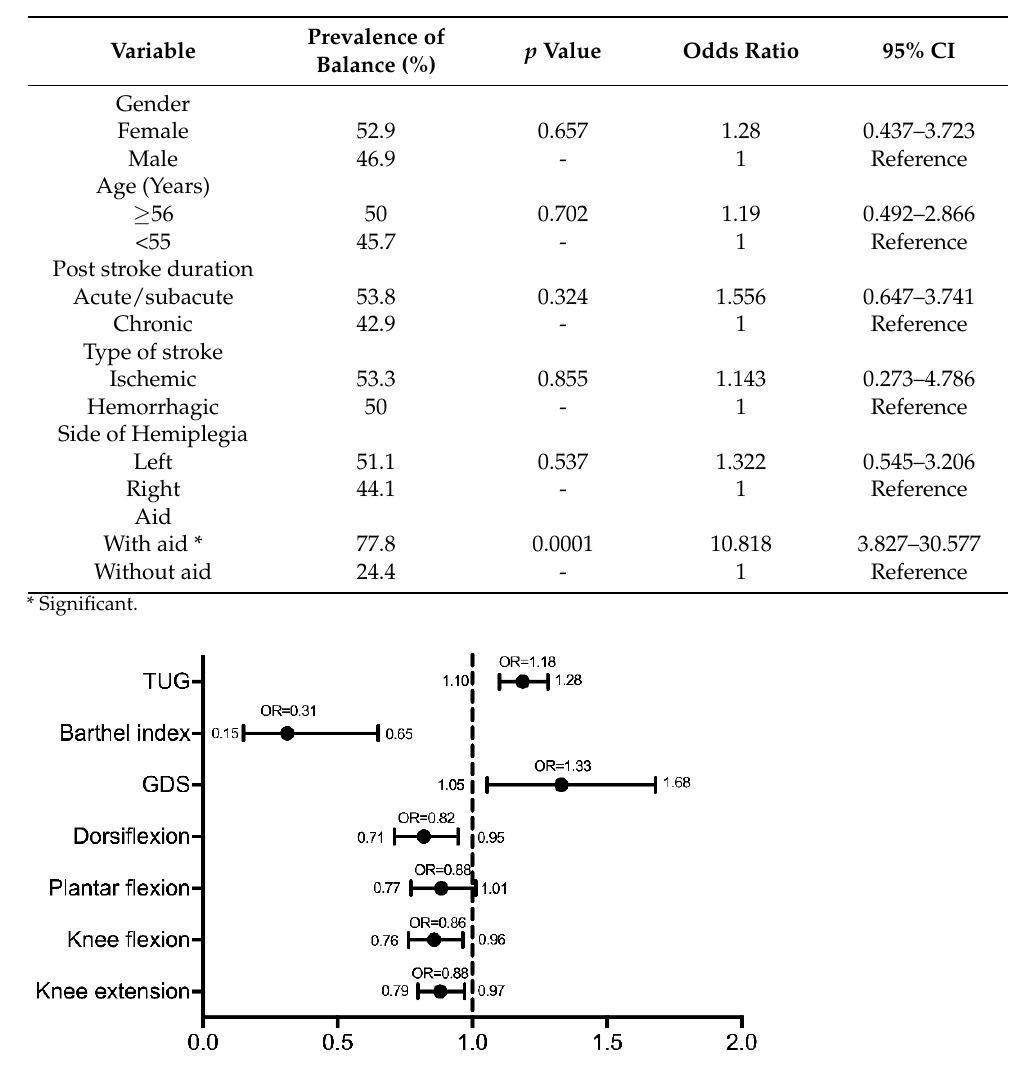
Table 2. Prevalence of balance for different variables and factors affecting balance.